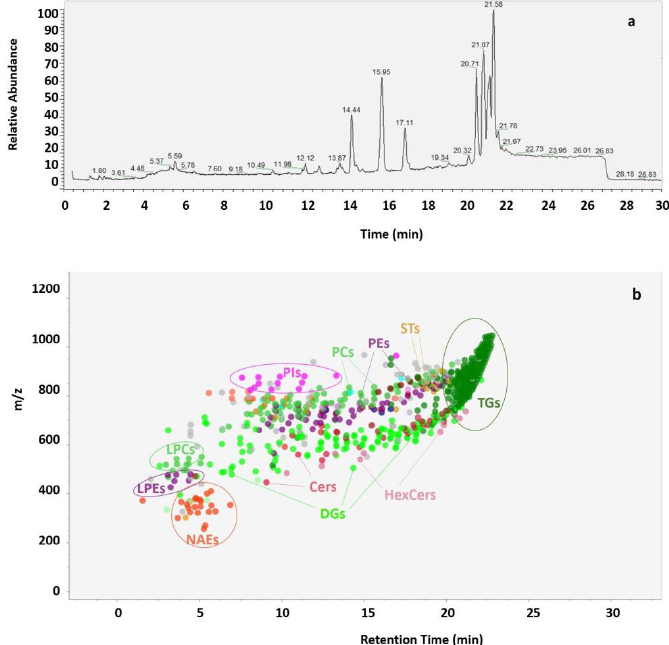
Figure 3. Example of UHPLC-Q-Extractive Orbitrap MS chromatogram acquired in positive ioniza- tion mode obtained from lipids extracted with MTBE-ME from a sample of rice bran ( a ). Spot viewer with m/z and retention time of different lipid classes (NAEs (orange), PEs and LPEs (purple), PCs and LPCs (green), PIs (fuchsia), Cers (red), HexCers (pink), DGs (light green), TGs (dark green) and STs (beige) ( b ).